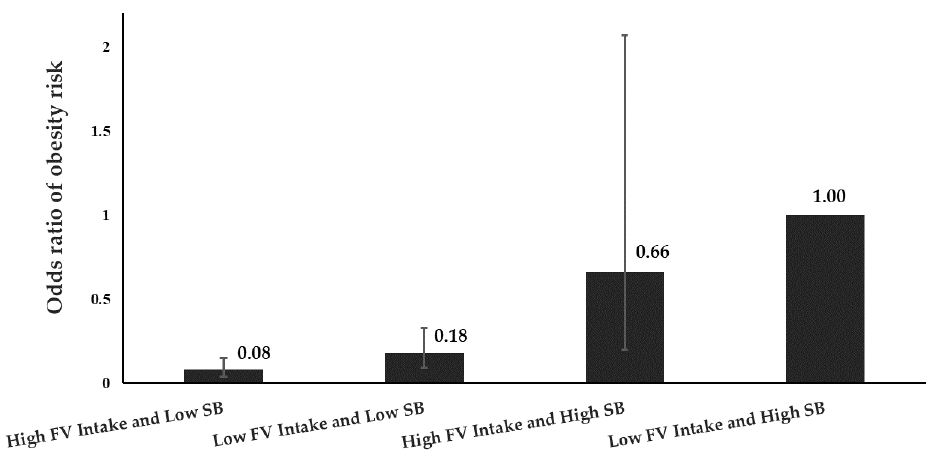
Figure 1. The interaction between daily fruit and vegetable intake and sedentary behavior. We generated the odds ratios, and p -value from conditional multiple logistic regression after adjusting for sex, age of the child, residence, mother’s education, household expenditure, TV ownership, and calorie intake. FV is fruit and vegetables. SB is sedentary behavior.